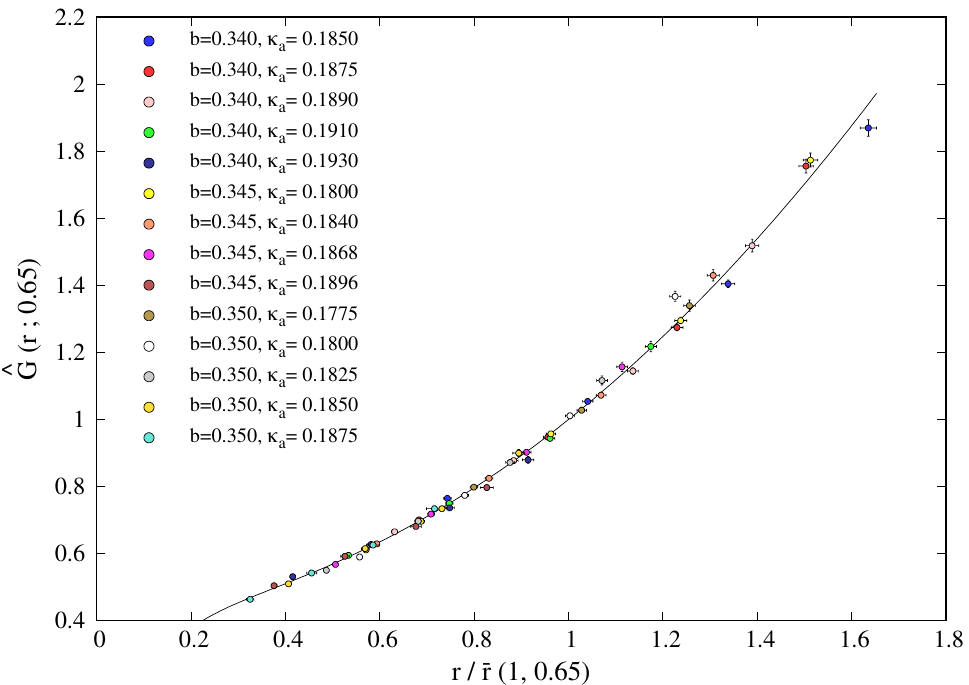
Figure 7. For all our N = 361 data samples, we display ˆ G ( r ; 0 . 65) as a function of r/ ¯ r (1 , 0 . 65) , where ¯ r (1 , 0 . 65) is the scale determined using eq. (5.12) setting f 0 = 1 and s = 0 . 65 . The black line is obtained by doing a joint fit of all the data with R > 1 . 5 to eq. (6.8), as described in the